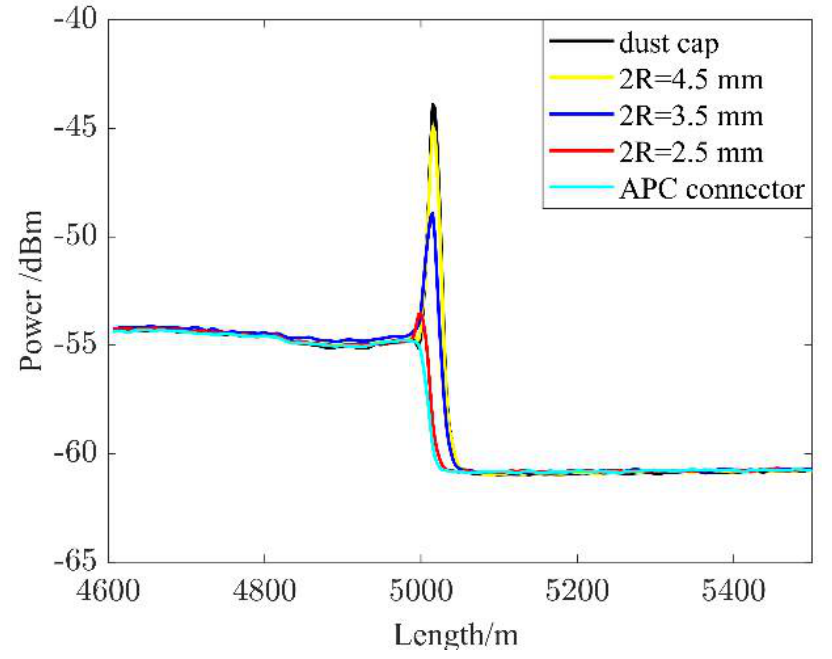
Figure 7. Measured Fresnel reflection signal with different coil radii.